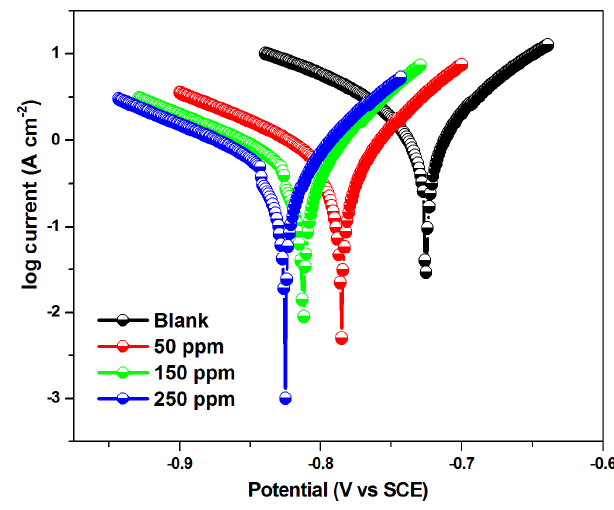
Figure 3. Tafel polarization plots at various concentrations of T. aralioides .